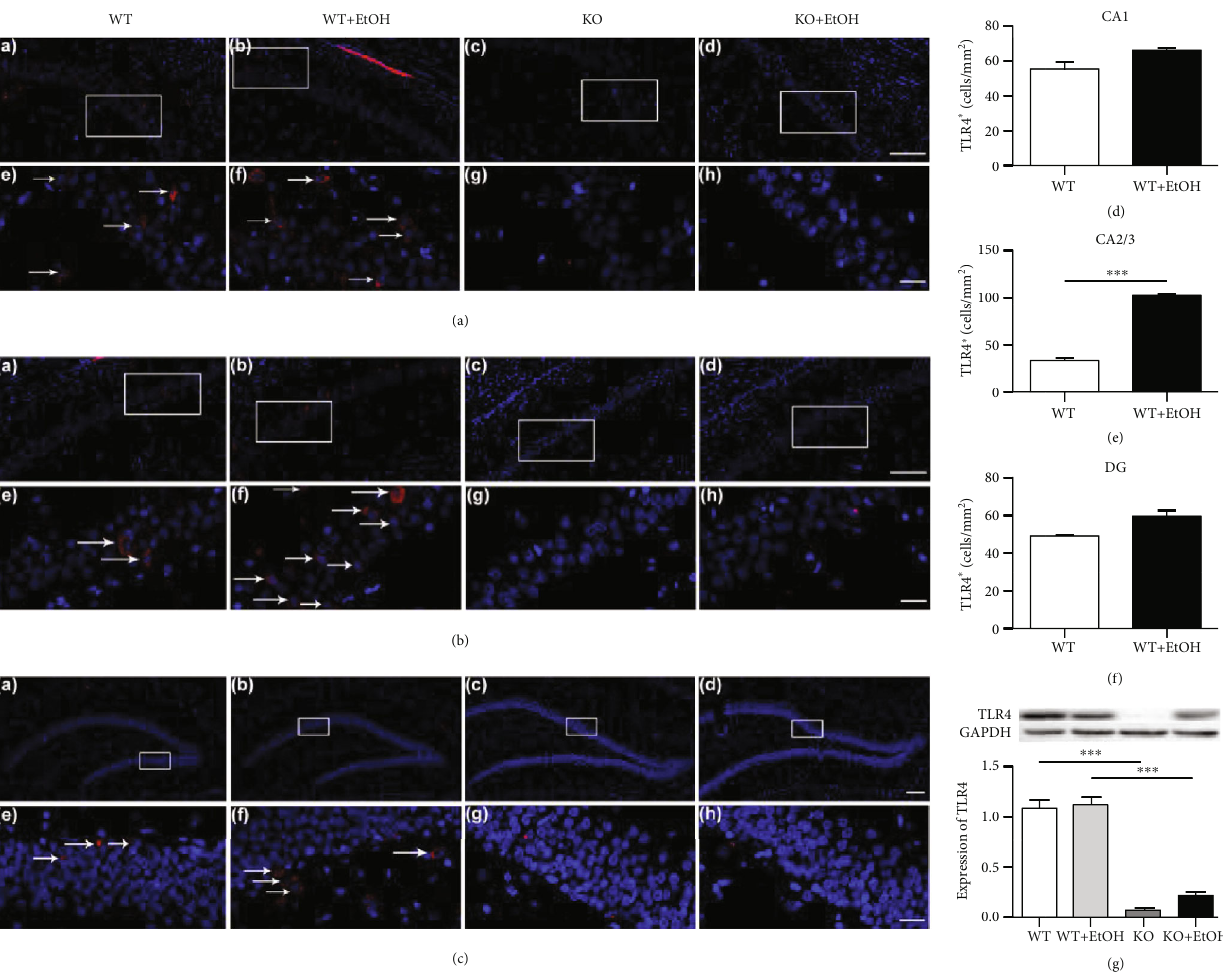
Figure 3: E ff ect of ethanol exposure on the TLR4 expression in the hippocampus. Representative photomicrographs of level-matched coronal sections of CA1 (a, A – H), CA2/3 (b, A – H), and DG (c, A – H) from WT (A, E), WT+EtOH (B, F), KO (C, G), and KO+EtOH (D, H) rats. White arrows indicate TLR4 + cells. Regions of interest (framed areas) in A – D are presented in E – H. Scale bar: 100 μ m in A – D; 20 μ m in E – H. WT =control rats without ethanol; WT+EtOH =control rats with ethanol; KO=TLR4 knockout rats without ethanol; KO+EtOH=TLR4 knockout rats with ethanol. CA1 = fi eld CA1 of the hippocampus; CA2/3 = fi eld CA2-3 of the hippocampus; DG=dentate gyrus of the hippocampus. Quanti fi cations of TLR4 + cells from WT and WT+EtOH rats are shown in (d) (CA1), (e) (CA2/3), and (f) (DG). The number of TLR4 + cells was averaged from fi ve random areas across each region in consecutive three sections of each rat. Data are presented as the mean number of Iba-1 + cells/mm 2 ± S : E : M : ( n = 4 ). ∗∗∗ p < 0 : 001 . The hippocampal protein level of TLR4 (g) was measured by WB, and quantitative analyses were normalized to GADPH. Data are presented as the mean ± S : E : M . ∗∗∗ p < 0 : 001